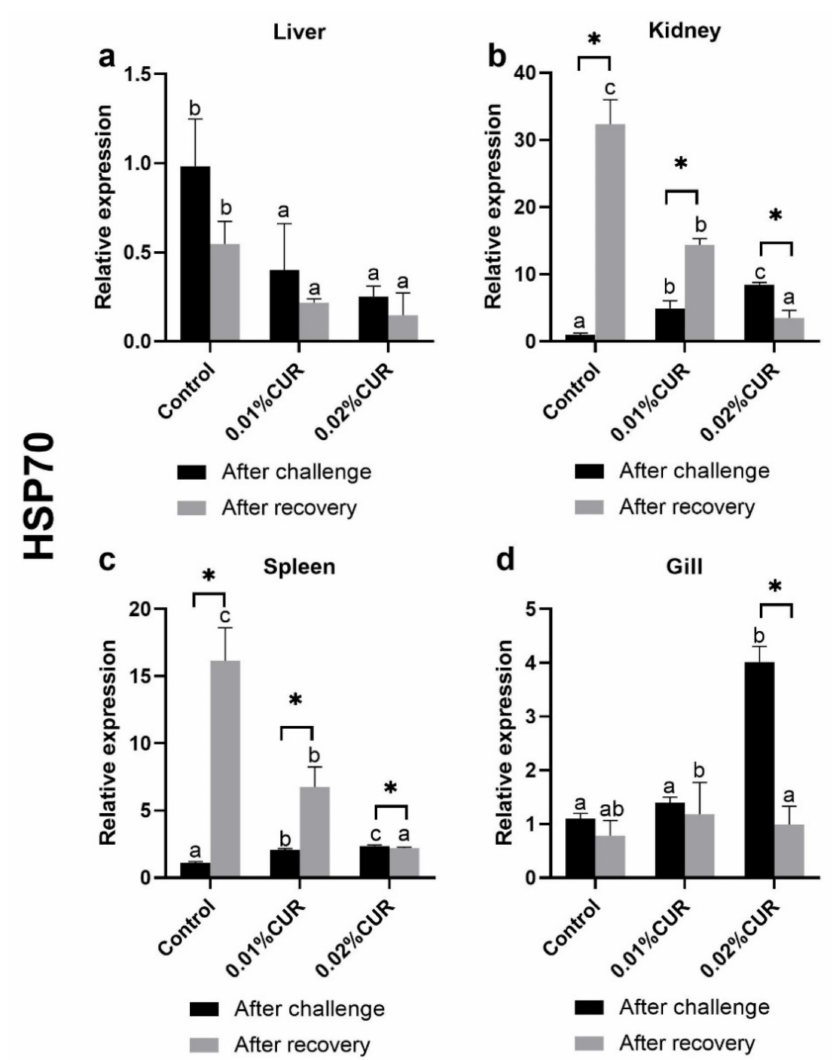
Figure 6. The relative expression of heat shock protein (HSP70) genes in ( a ) liver, ( b ) kidney, ( c ) spleen and ( d ) gill tissues of greater amberjack fed with dietary curcumin supplementation. (Different letters above bars and asterisk sign (*) indicate significant differences at the 0.05